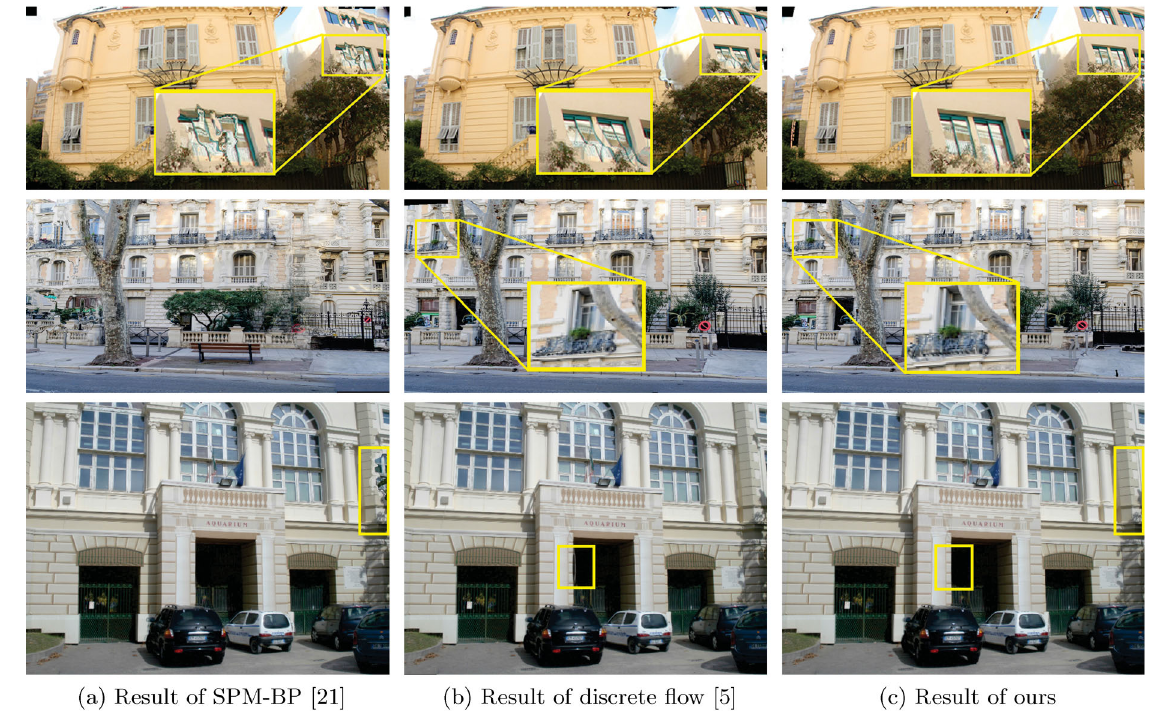
Fig. 12 Comparison with Refs. [5] and [21]. There are fewer artifacts in our